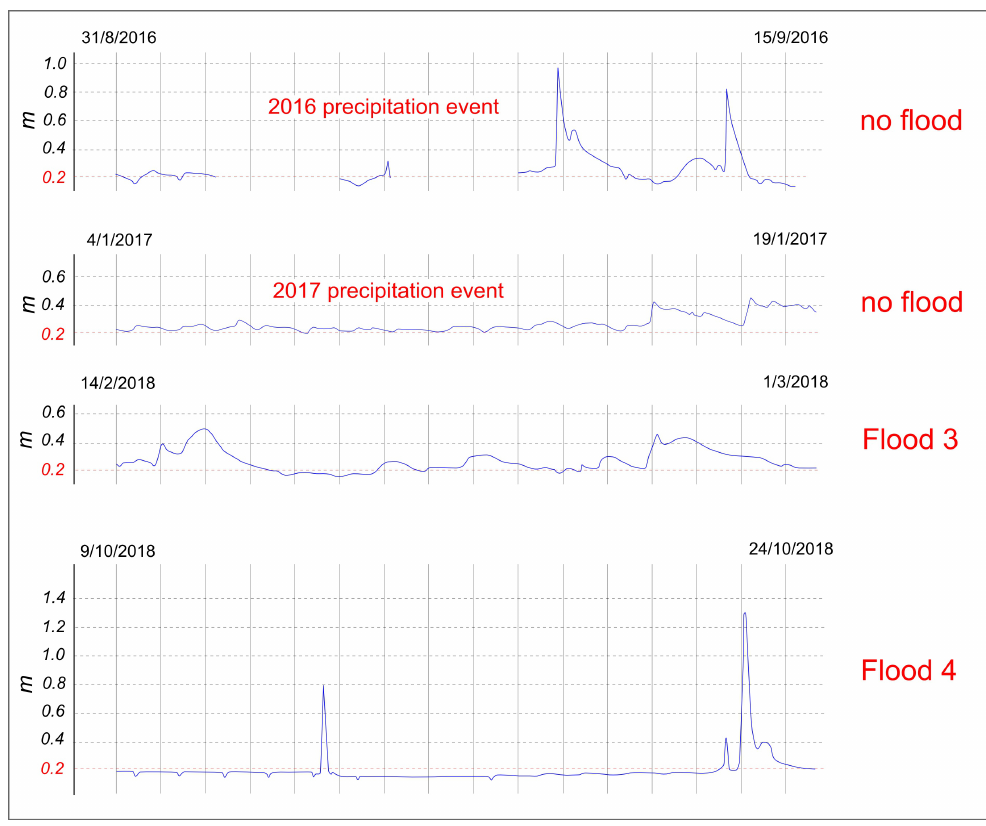
Figure 6. Hydrometric levels (m) recorded at the Canale Asso station (the rough data have been extracted weekly from [28]). Precipitation events and floods are reported in chronological order from top to bottom (see Table